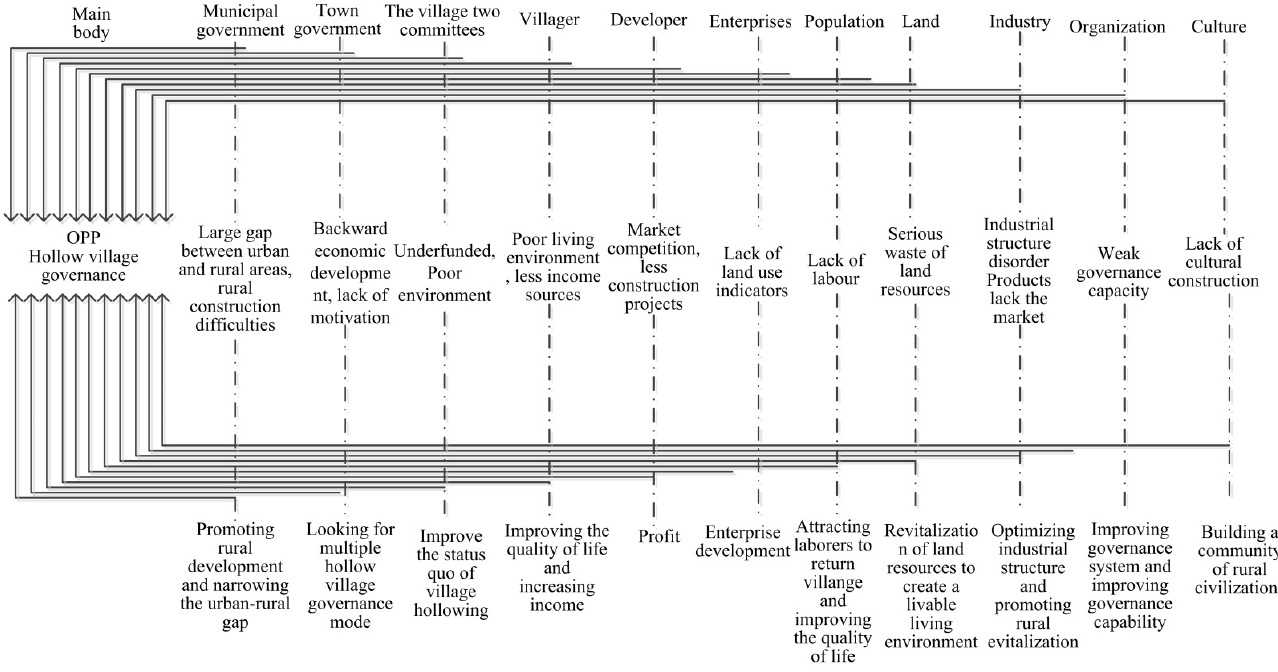
Figure 2. Actors of hollow village governance and their obligatory pass point (OPP).